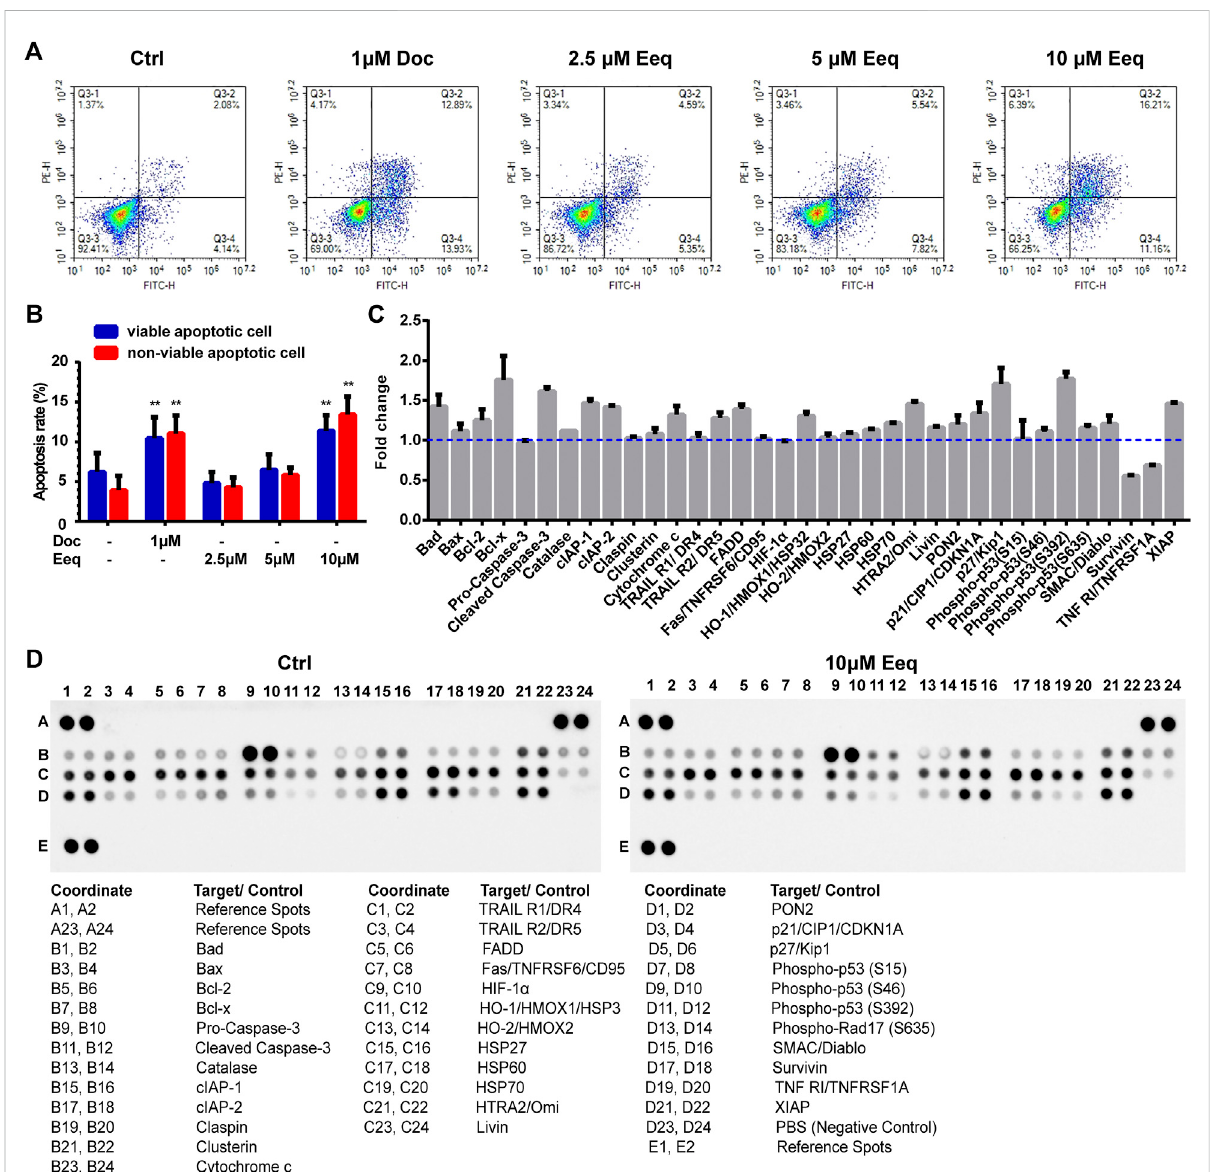
FIGURE 4 5 ′ -Epiequisetin(Eeq)inducedPC-3cell apoptosis. (A,B) Eeqinduced PC-3cellapoptosisinadose-dependentmanner. (C,D)